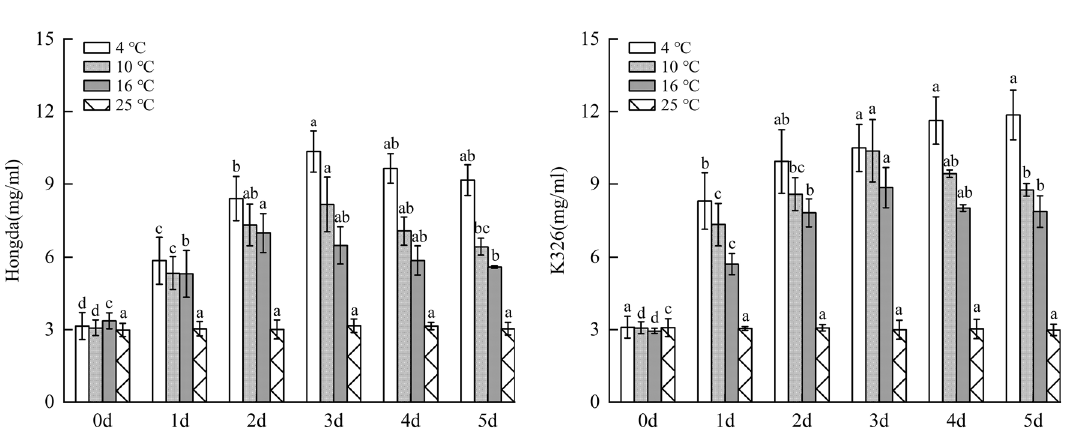
Figure 5. The changes of SS content under different low-temperature stresses. Different lowercase letters indicated that there were significant differences at different times under the same temperature treatment (P < 0.05). The values were the mean of three biological